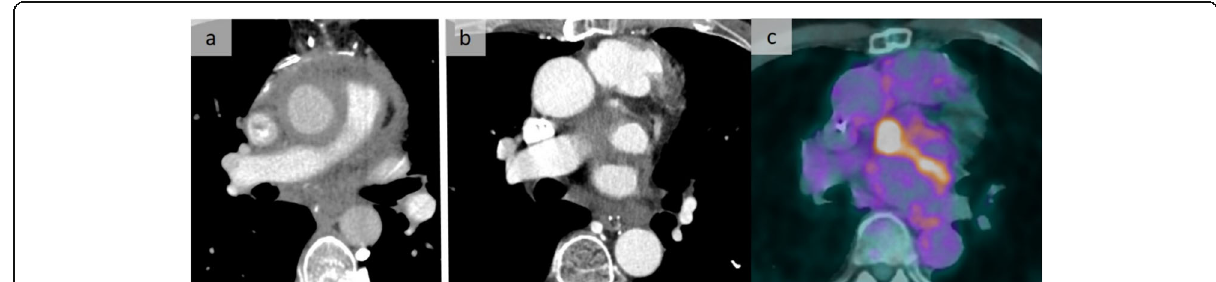
Fig. 14 Thymoma. Two cases of diffuse infiltration of the mediastinum from different causes. The first is related to a fibrosing mediastinitis ( a ), while the other corresponds to a recurrence of a histologically proven thymoma stage IVA ( b ), highly metabolic on PET/CT ( c ). Neither disorder can be differentiated morphologically